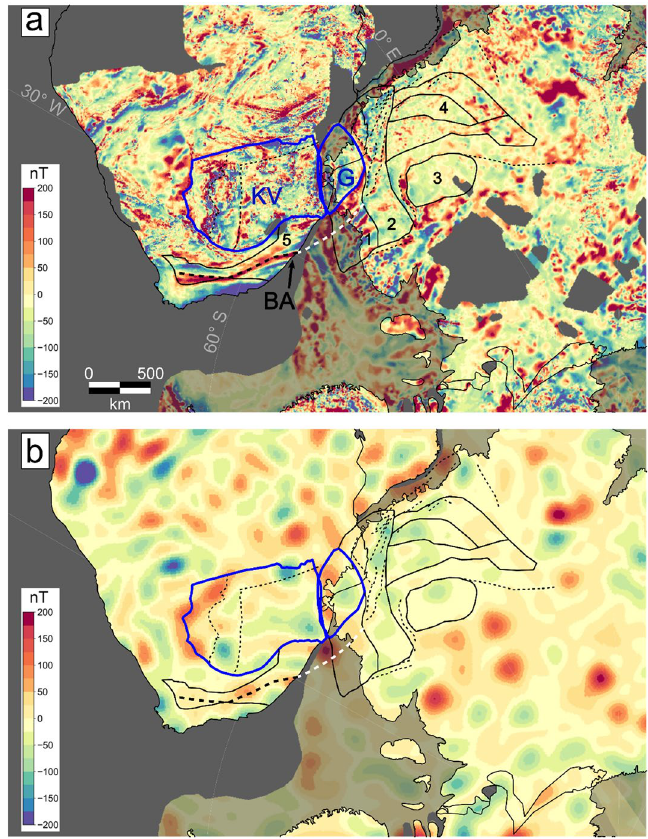
Figure 4. Zoom in on the South Africa-Antarctica connection. ( a ) Combined aeromagnetic-satellite model. The connecting cratons are marked as blue contours. KV: Kaapvaal, G: Grunehogna Craton. Beattie Magnetic Anomaly (BA) is indicated as thick dashed line. Solid black contours represent selected tectonic units of Antarctica older than 200 Ma. 1: Natal type terrane boundaries. 2: Maud Belt, 3: Valkyrie Craton, 4: Tonian Antarctic Super Terrane (TOAST). Contour 5: Natal terrane. Dashed lines indicate several fracture zones in South Africa and Dronning Maud Land, White dashed line: Continuation of the Beattie Magnetic Anomaly, ( b ) Satellite data LCS-1. Both data sets have been reduced to the pole and are represented at 5 km height. All data sets are rotated back to 200 Ma. Semi-transparent anomalies indicate aeromagnetic anomalies on the continental